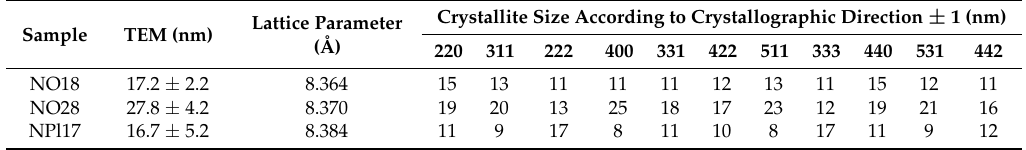
(XRD) Table 3. TEM size and lattice parameter and crystallites size determined from X-ray diffraction (XRD) refinement.